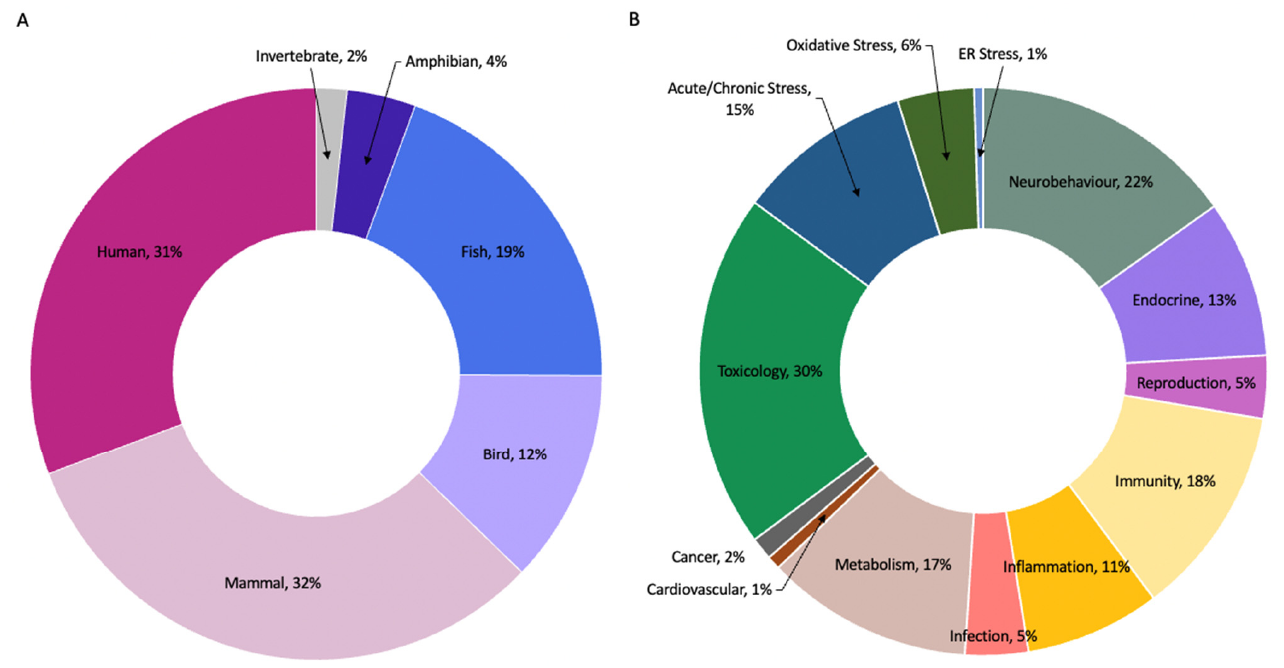
Figure 2. A review of the literature by ( A ) species and ( B ) physiological